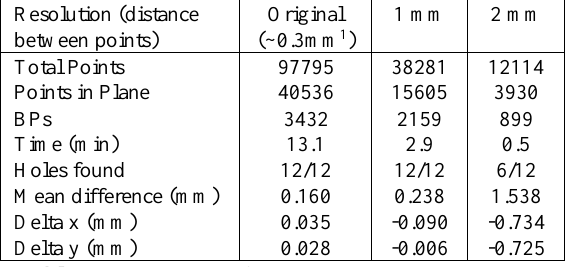
Figure 9: Circle centre discrepancies from two scans at opposing incidence angles; laser tracker reference in blue, laser scanner estimated in red